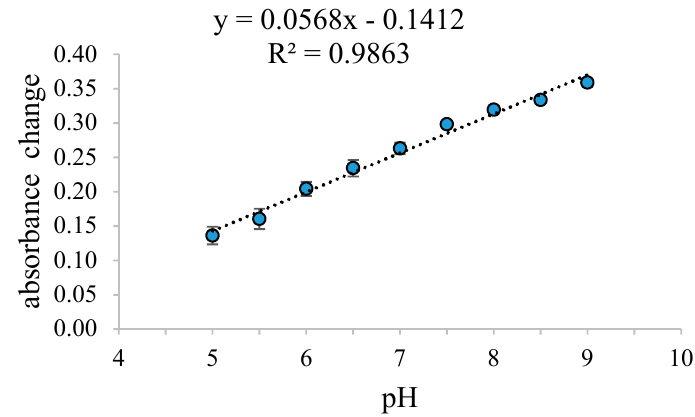
Figure 4. The response of the Pe/CI optical pH sensor in a pH range of 5–9.